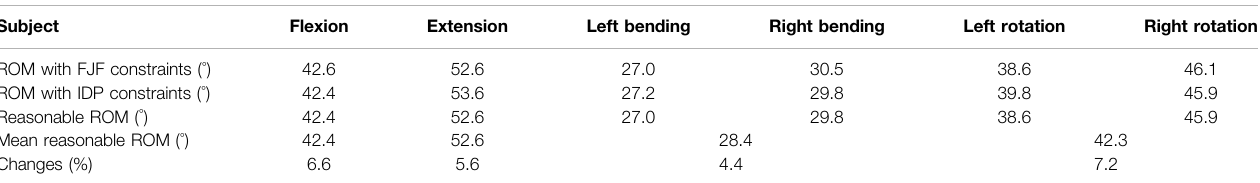
TABLE 2 | Reasonable total C0 – C7 ROM with FJF and IDP